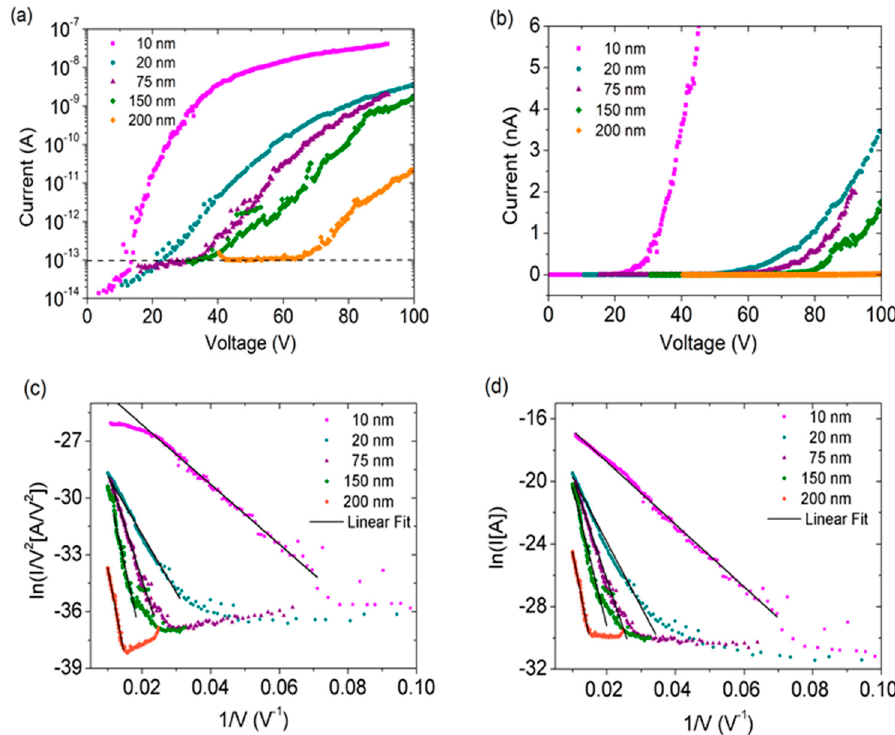
Figure 4. ( a ) Field emission current plotted as a function of applied voltage in semilogarithmic scale; the black line identifies the current level at which the turn-on field is defined; ( b ) Field emission current plotted as a function of applied voltage in linear scale; ( c ) Experimental data plotted with 3D Fowler–Nordheim model; ( d ) Experimental data plotted with modified 2D Fowler–Nordheim model, showing good fit over a wider range.